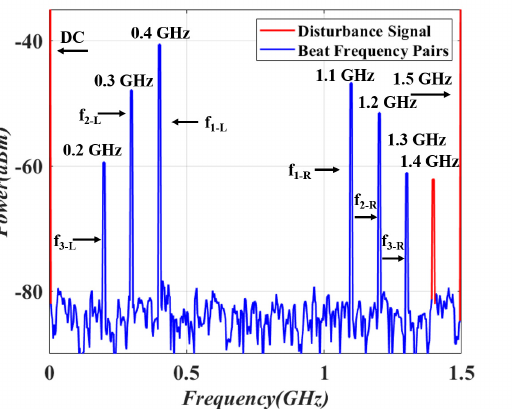
Figure 9. Measurement result using a multi-tone signal, where f 1 = 1.9 GHz, f 2 = 3.3 GHz and f 3 = 10.7